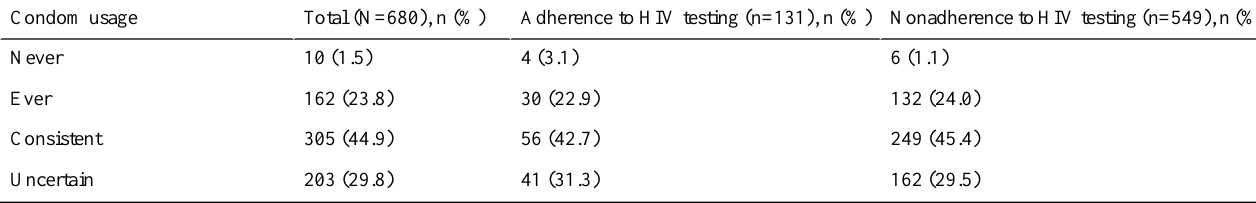
Table 4. Comparison of baseline condom use behaviors in the adherence and nonadherence